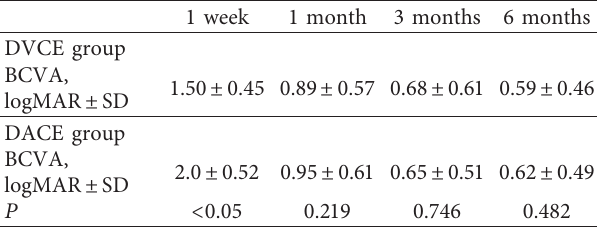
Table 3: Best-corrected visual acuity after the